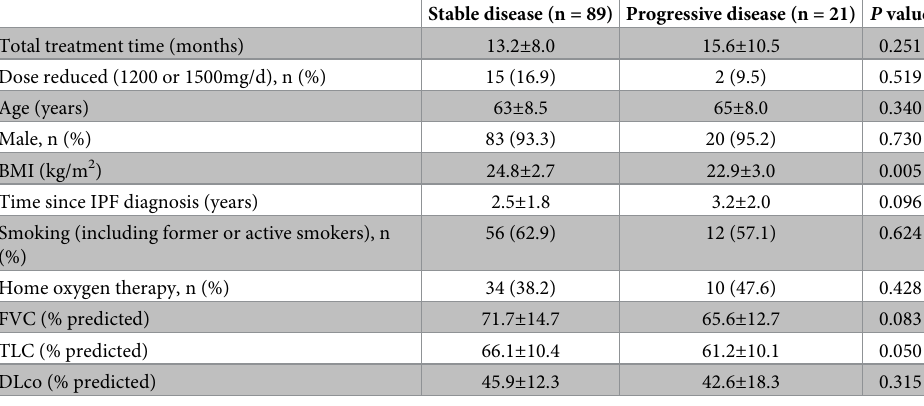
Table 3. Baseline characteristics in stable and progressive